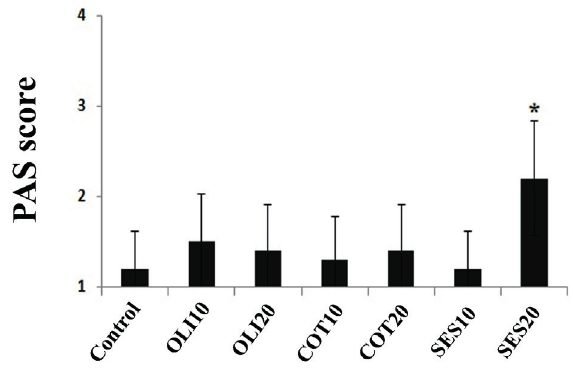
Figure 2 - Quantitative analysis of PAS-positive deposits. Control, Olive 10% (OLI10), Olive 20% (OLI20), Cottonseed 10% (COT10), Cottonseed 20% (COT20). Sesame oil 10% (SES10) and Sesame oil 20% (SES20). Values were presented as mean± SD. * p< 0.05 compared with the control